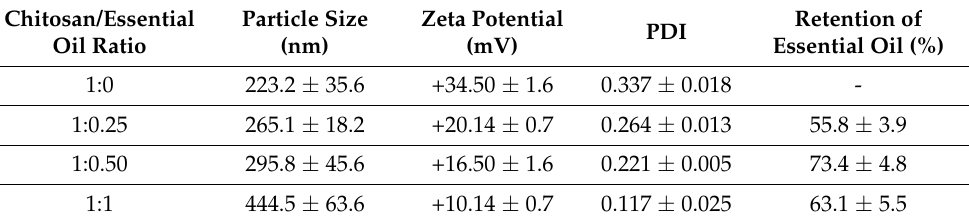
Table 8. Particle size, zeta potential, polydispersity index (PDI), and retention value of clove essential oil-loaded CSNPs